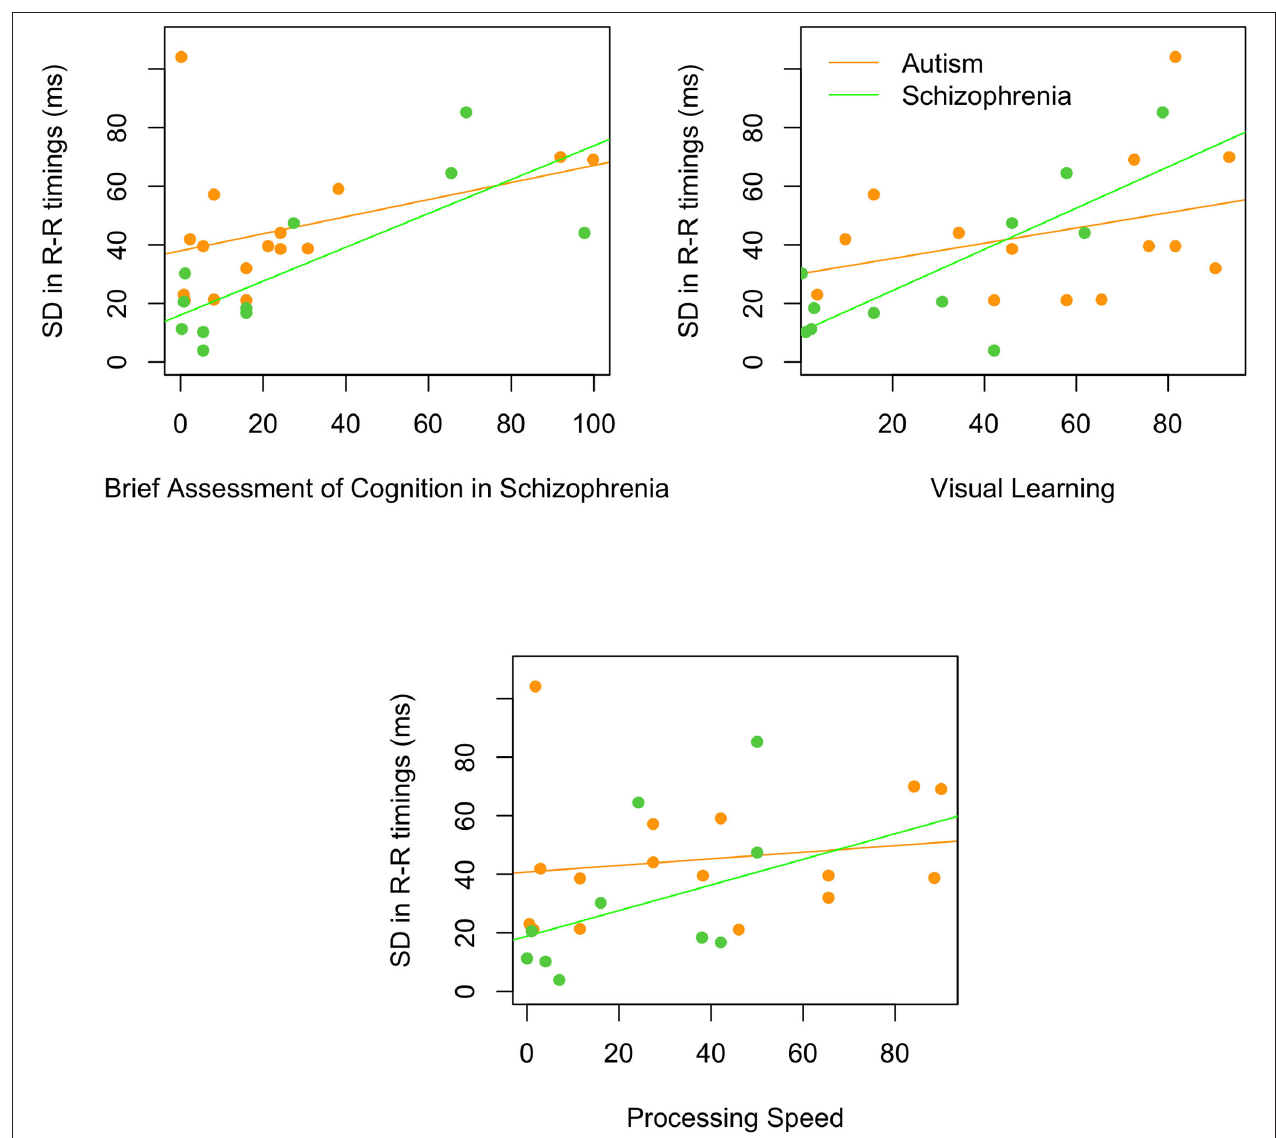
FIGURE 3 | Relationships between SDNN and the Brief Assessment of Cognition in Schizophrenia, visual learning, and processing speed. All correlations were significant in the schizophrenia (green) and not the autism (orange)